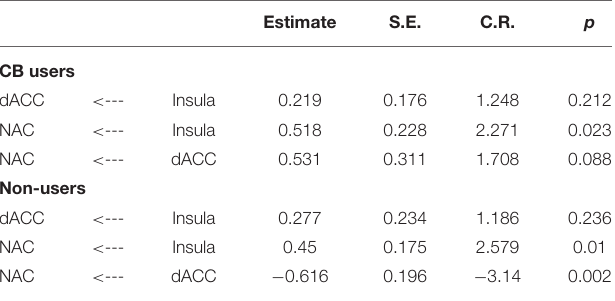
TABLE 4 | Effective connectivity parameter